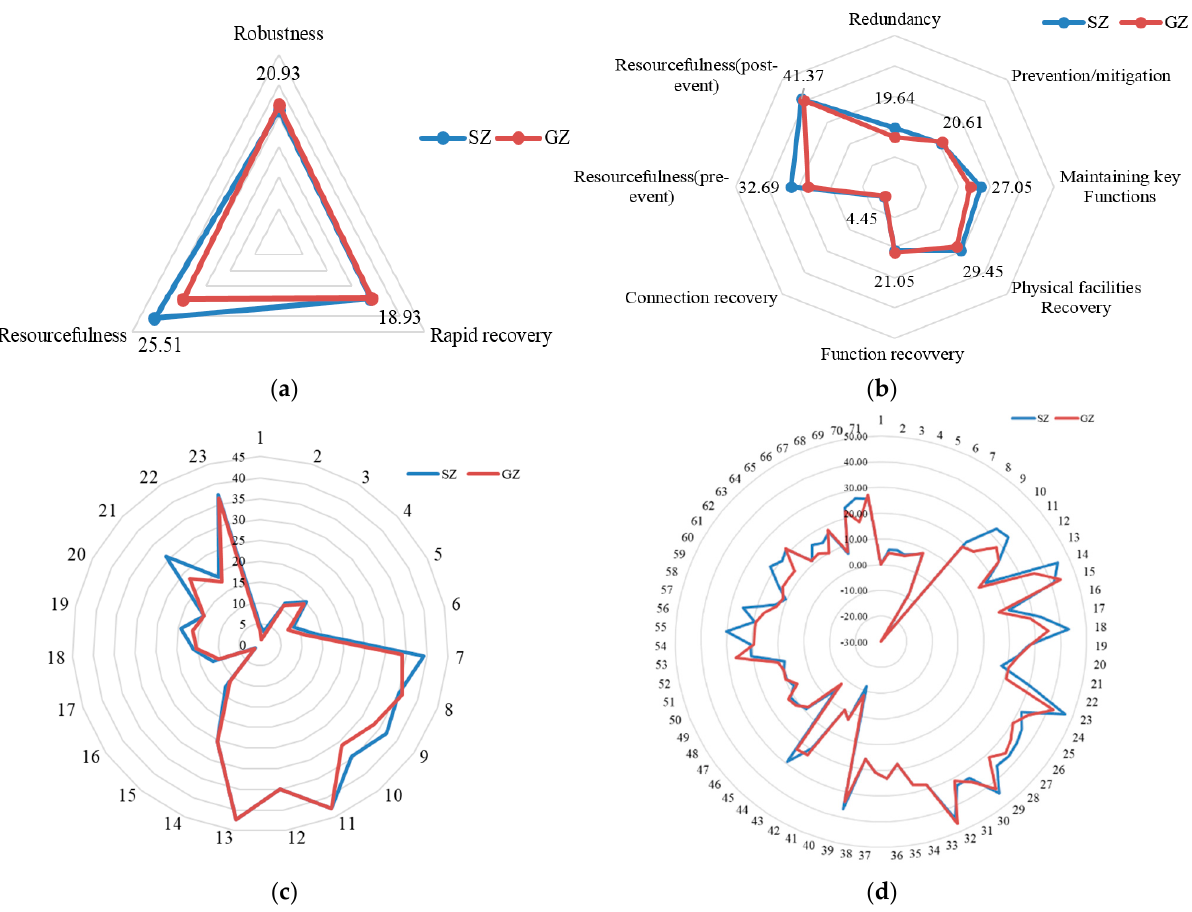
Figure 2. Resilience values of the indicators in ( a ) level 2, ( b ) level 3, ( c ) level 4, and ( d ) level 5. Note: The representations of the numbers in ( c , d ) are shown in Appendix Tables A1–A3.